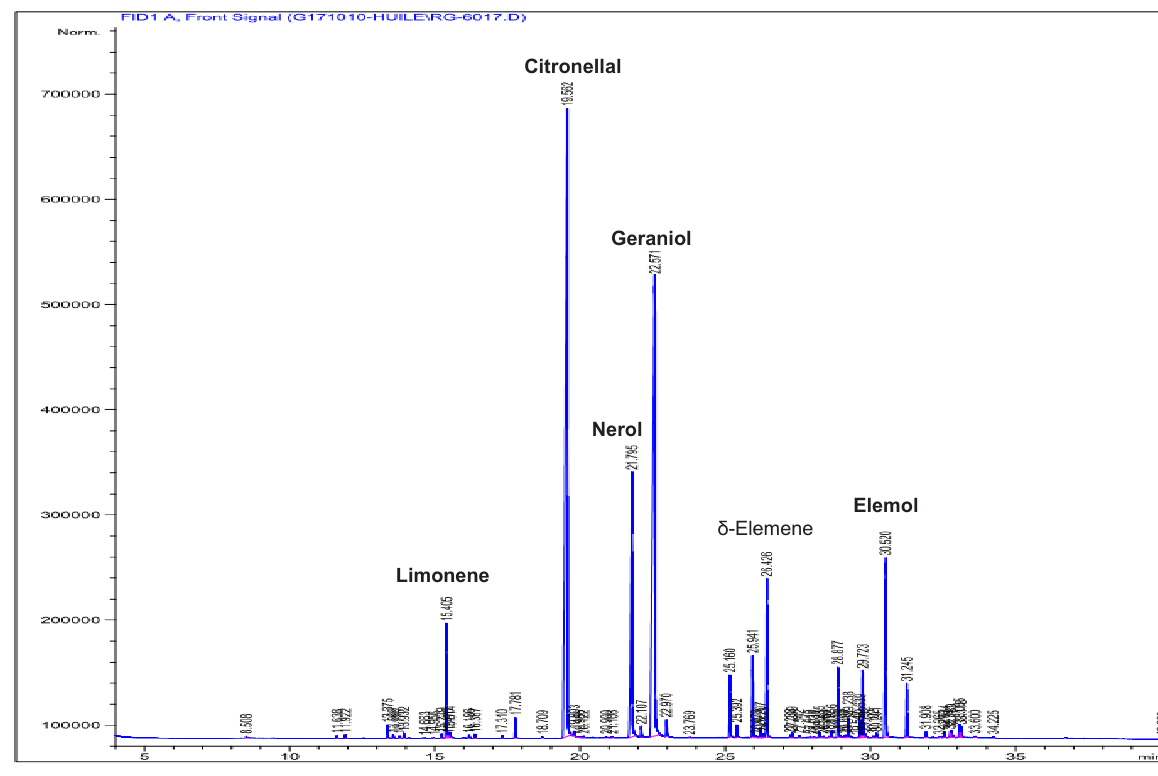
Figure 1: Chromatograms of the essential oil Cymbopogon nardus with its major compounds identified.